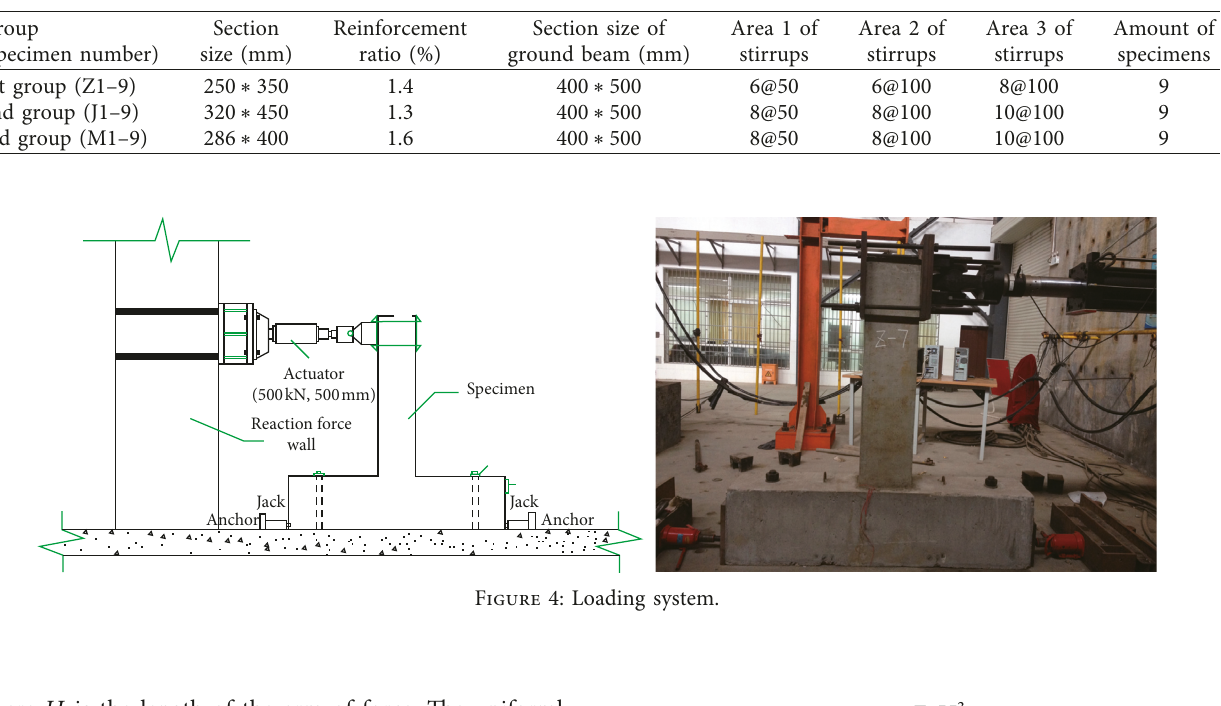
Figure 3: Size and reinforcement of the third group of test members. Table 1: Basic parameters of test members.